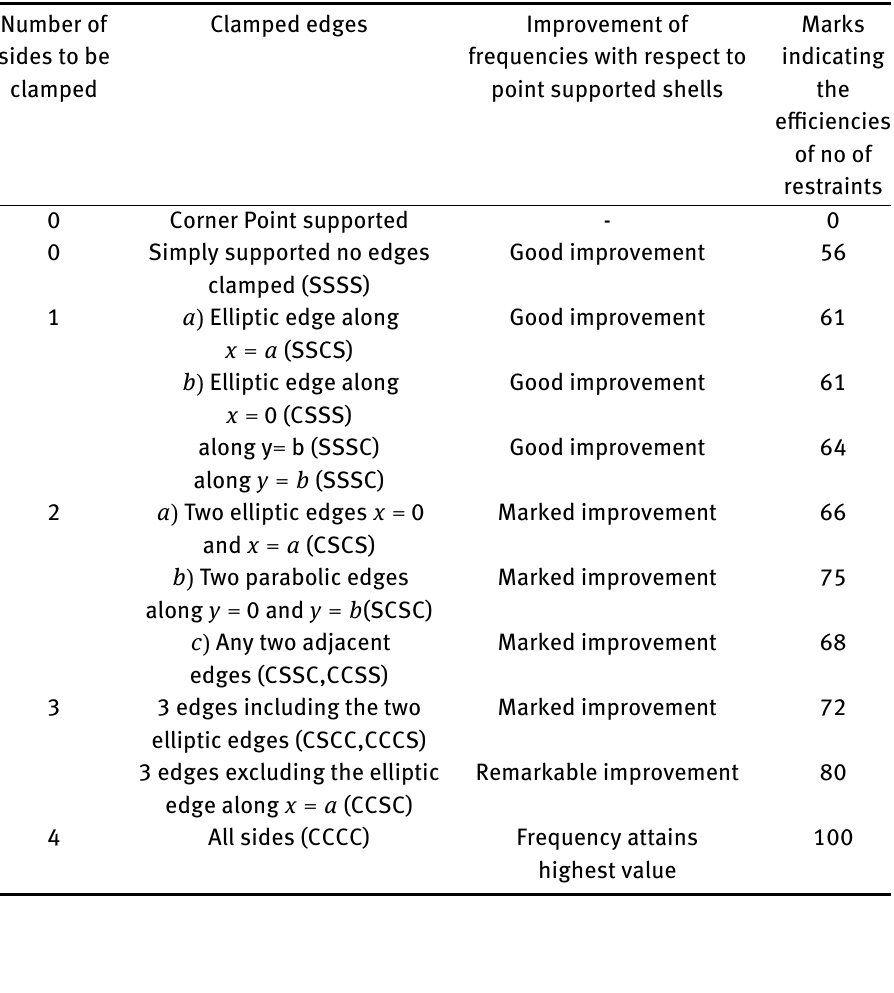
Table 6: Clamping options for + 45/-45/ + 45/-45 elliptic parabolic shells with central cutouts having a / / a ratio 0.2.